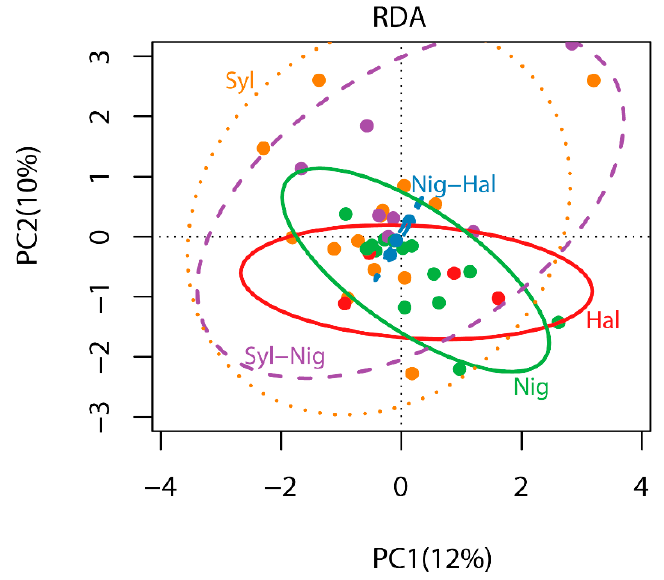
Figure 2. philR RDA ordination based on Euclidean distance matrix displaying ectomycorrhizal phylogenetic community composition of P. halepensis , P. nigra-halepensis , P. nigra , P. sylvestris-nigra and P. sylvestris forest and the sd ellipses of each forest.